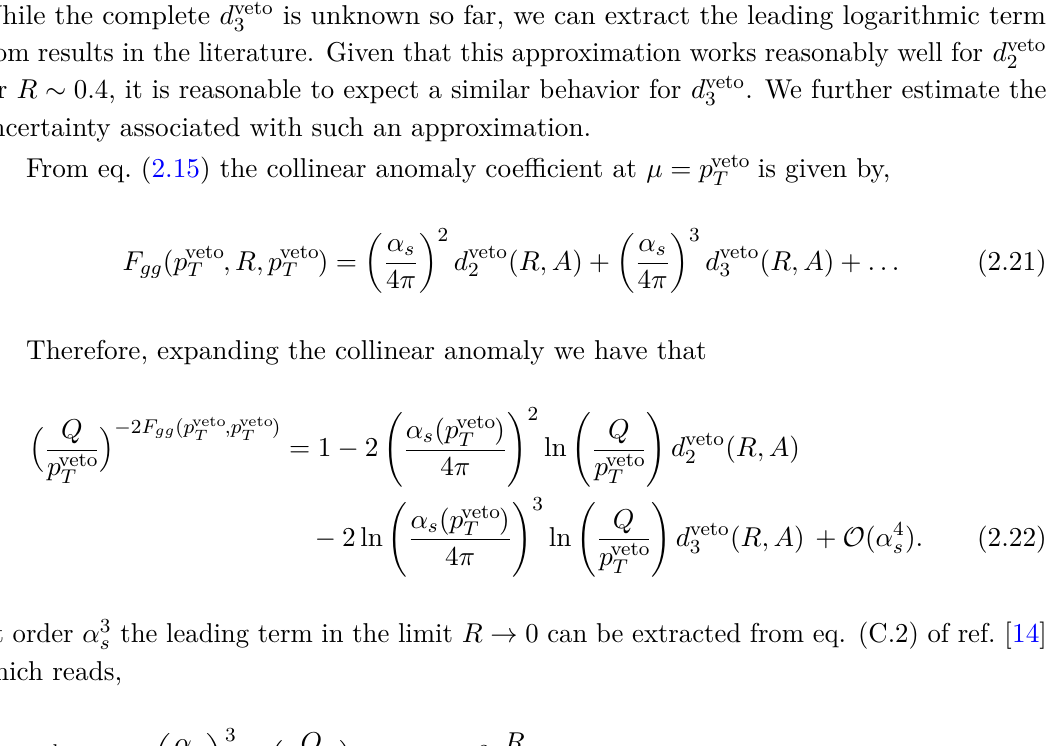
Figure 2 . Effect of R 0 variation in d veto compared to the case d veto